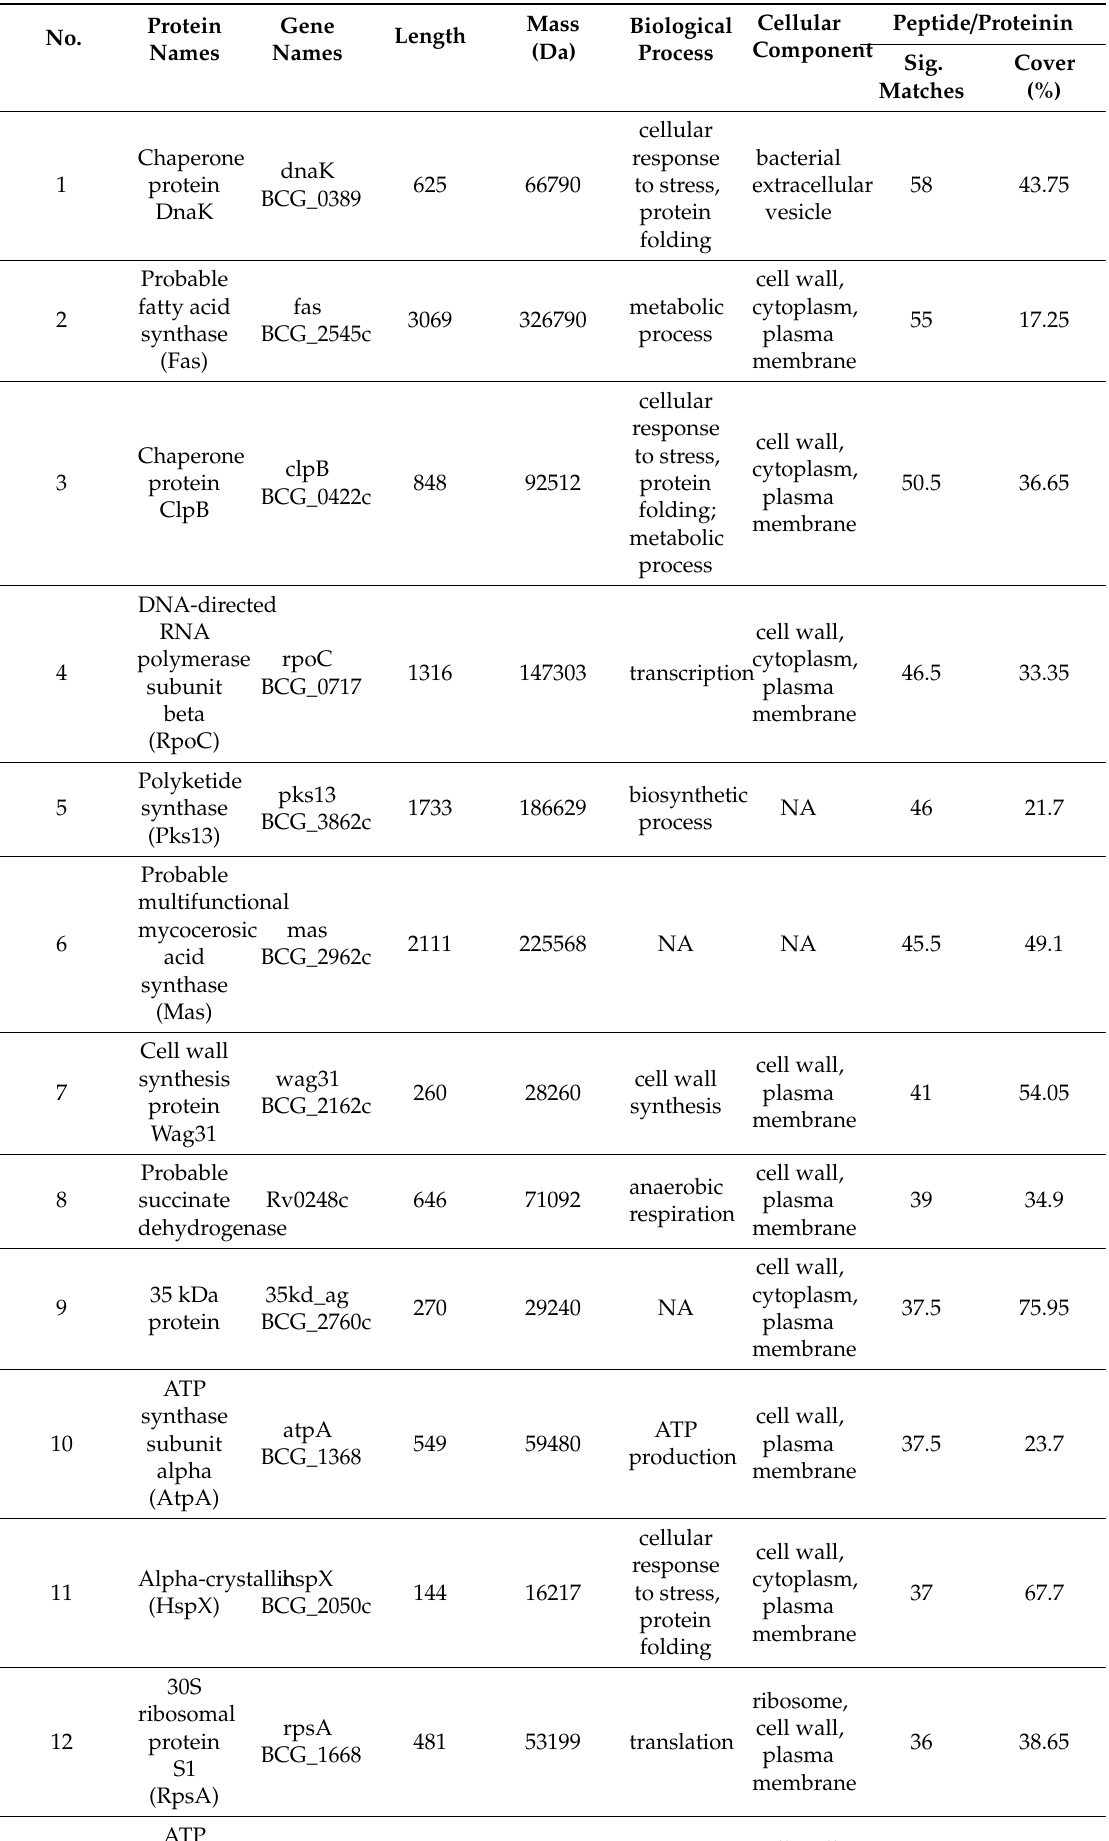
Table 1. Molecular and functional characteristics of proteins proteomically identified in A60.